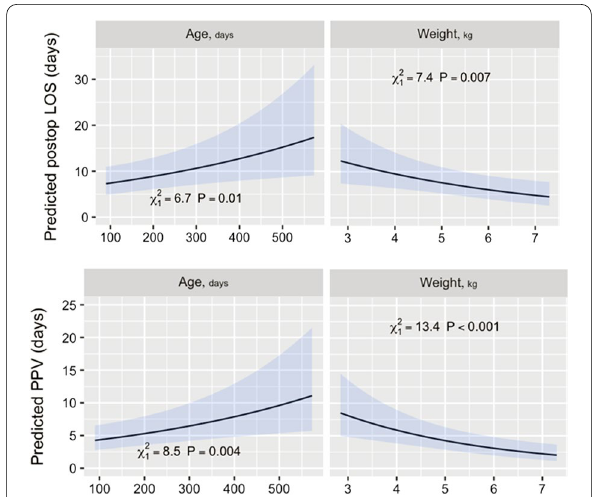
Fig. 1 Predicted postoperative in‑hospital length of stay (LOS) and positive pressure ventilation (PPV) for age and body